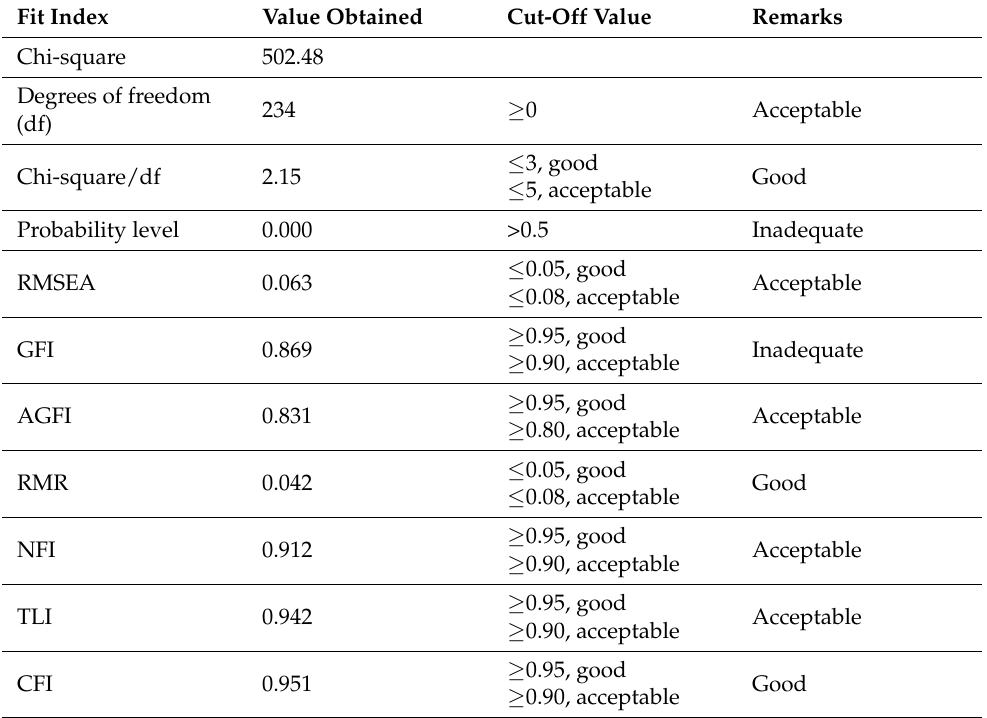
Table 6. Model fit indices